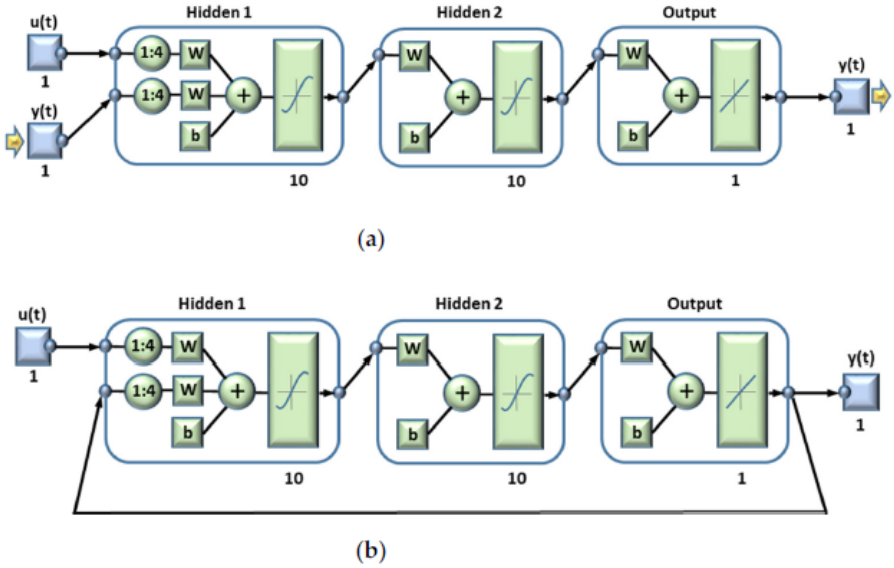
Figure 6. Architecture of configured NARX networks: ( a ) serial–parallel architecture (open loop); ( b ) parallel architecture (closed loop) [20].